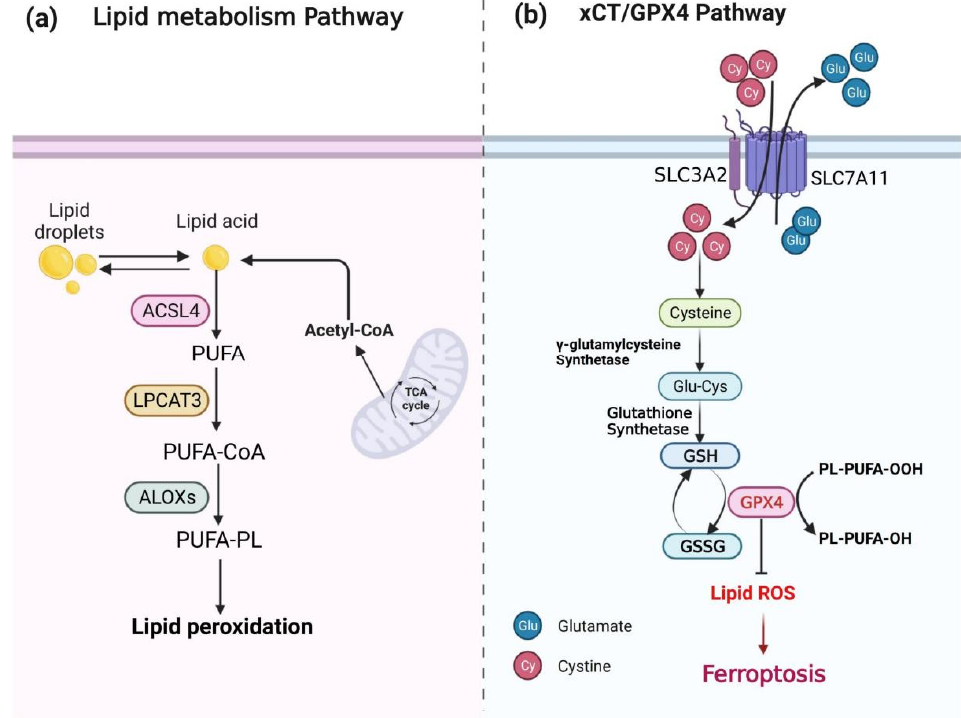
Figure 2. Molecular mechanisms of ferroptosis. ( a ) The lipid metabolism pathway; ( b ) the xCT/GPX4 pathway. ACSL4, long-chain fatty acid CoA ligase 4; PUFA, polyunsaturated fatty acid; LPCAT3, lysophosphatidylcholine acyltransferase 3; PUFA-CoA, polyunsaturated fatty acid coenzyme A; ALOXs, lipoxygenases; PUFA-PL, polyunsaturated fatty acid-containing phospholipid; TCA, tricarboxylic acid cycle; GSH, glutathione; GSSG, glutathione disulfide; GPX4, glutathione peroxidase 4.